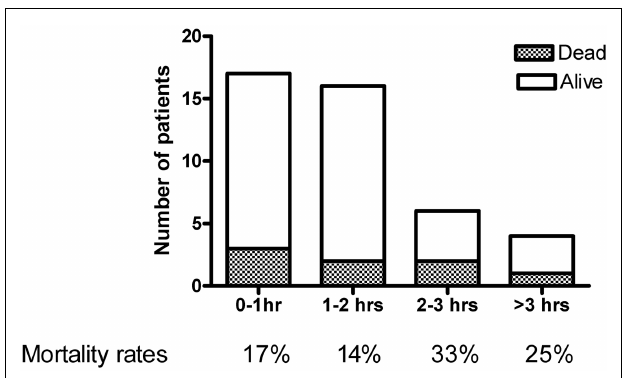
FIGURE 2 |Time to adequate antibiotics in hours, and relation to mortality rate .The figure includes severe sepsis and septic shock patients ( n = 43) admitted to the ICU directly from the emergency department.